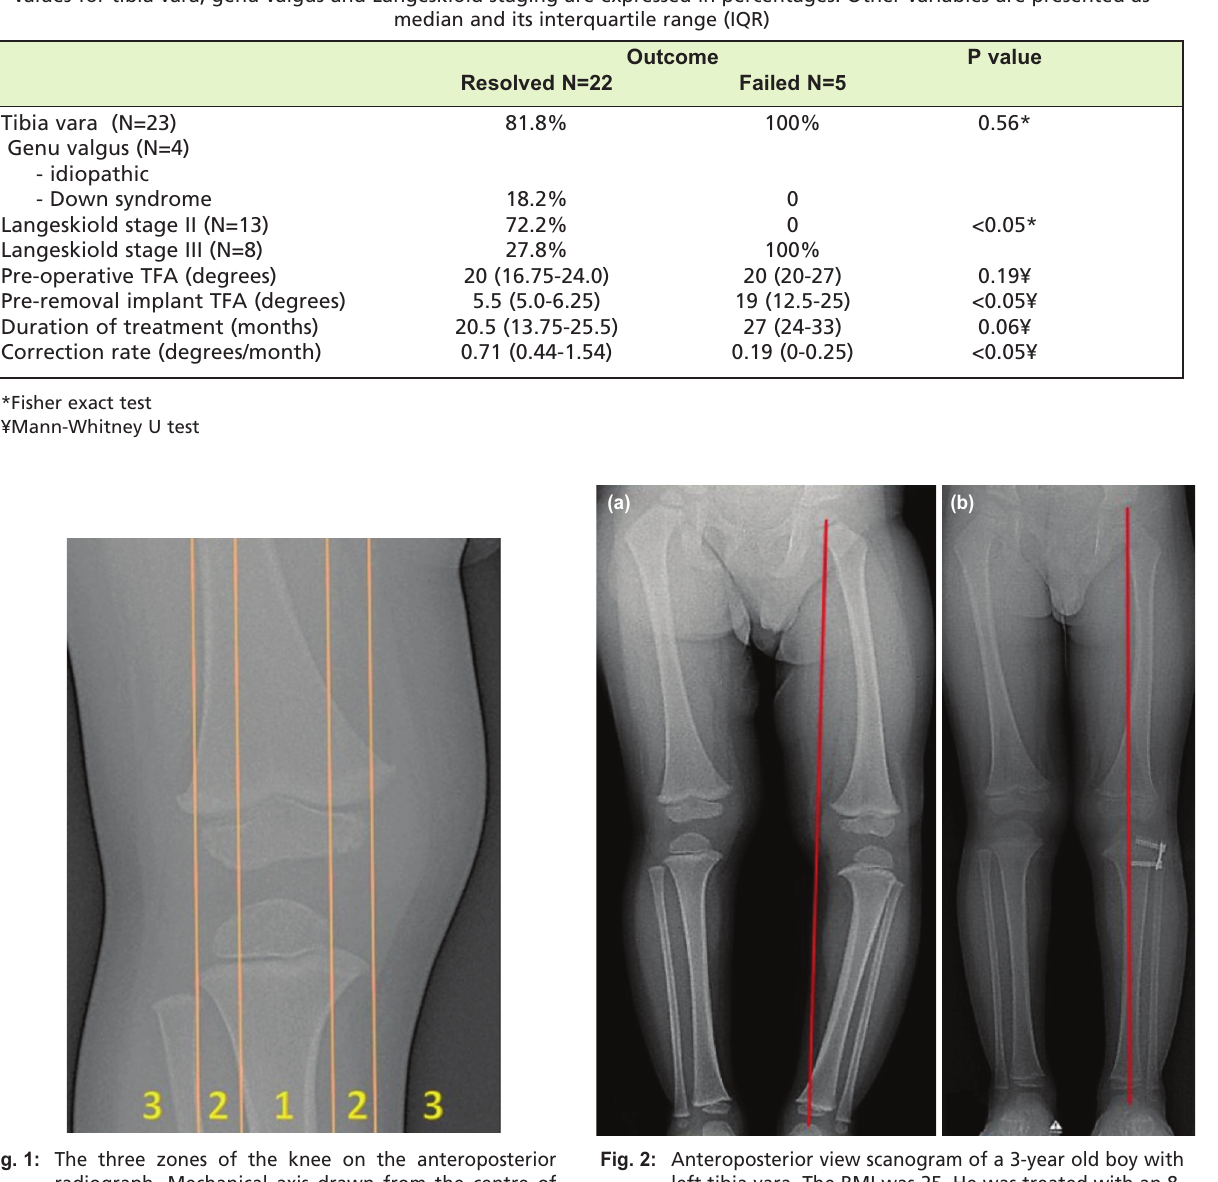
Comparison between the successful and failed outcomes of angular deformity correction for different variables. The Table II: values for tibia vara, genu valgus and Langeskiold staging are expressed in percentages. Other variables are presented as